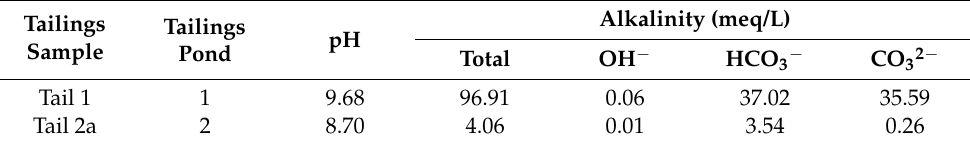
Table 6. Remaining charge balance via PHREEQC